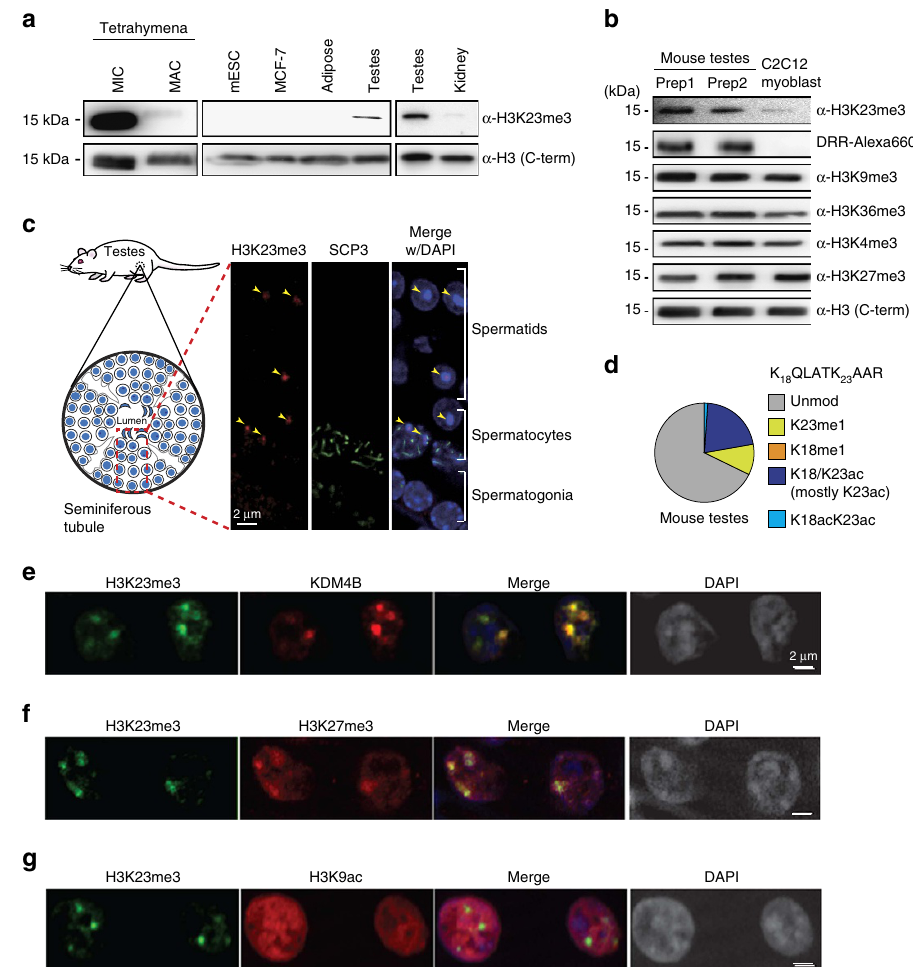
Figure 5 | H3K23me3 is enriched in spermatocytes. ( a ) Specific expression of H3K23me3 in different mouse tissues and mammalian cell lines. MIC (micronuclei) and MAC (macronuclei) histones from Tetrahymena , histones extracted from mouse tissues (testes, adipose and kidney) and mammalian cell lines (mESC, C2C12 and MCF-7) are probed with histone antibodies in a western blotting format. ( b ) Germline-enriched H3K23me3 detected by H3K23me3 antibody and DRR reader. Histones extracted from mouse testes tissues and C2C12 mouse myoblast cell line are probed with histone antibodies or engineered reader domain in a western or far western blotting format. ( c ) Immunofluorescence identifies H3K23me3 enrichment in meiotic cells. Mouse testes are probed with H3K23me3 (red) and SCP-3 (green) antibodies, and overlapped with 4,6-diamidino-2-phenylindole (DAPI) stain (blue; scale bar, 2 m m). Yellow arrows highlight H3K23me3 foci. ( d ) MS quantification of modifications on H3K23-containing peptide. ( e ) KDM4B (red) shows co-localization with H3K23me3 (green) by indirect immunofluorescence in rat testes (scale bar, 2 m m). ( f , g ) H3K23me3 (green) is localized at heterochromatin rather than active chromatin as suggested by co-localization with H3K27me3 (red in f ) but not H3K9ac (red in g ; scale bar, 2 m